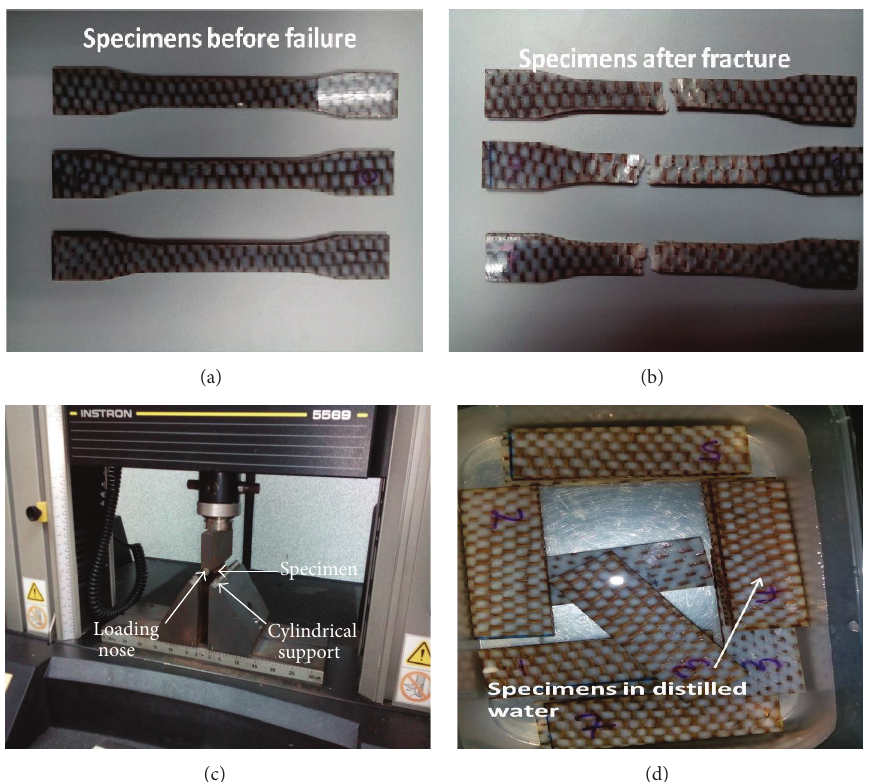
Figure 6: Mechanical testing and water absorption behaviour. (a) Tensile specimens before the test. (b) Tensile specimens after fracture. (c) Short beam test. (d) Fully saturated specimens in distilled